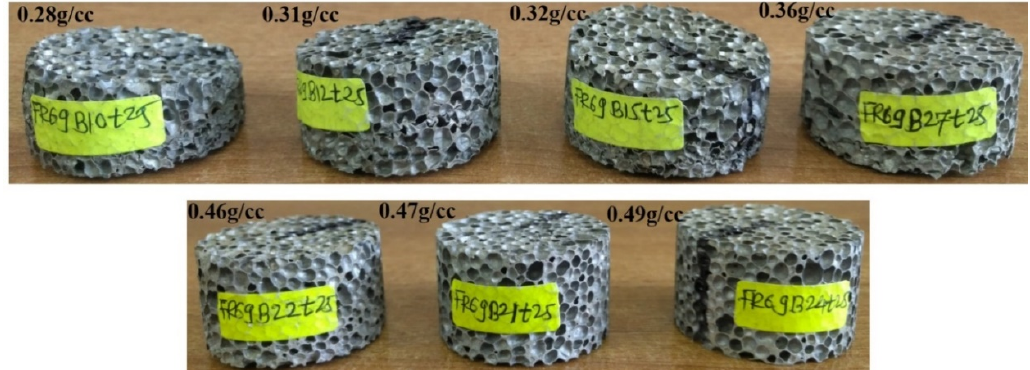
Figure 4. Aluminum foam samples of increasing foam density after shock exposure.